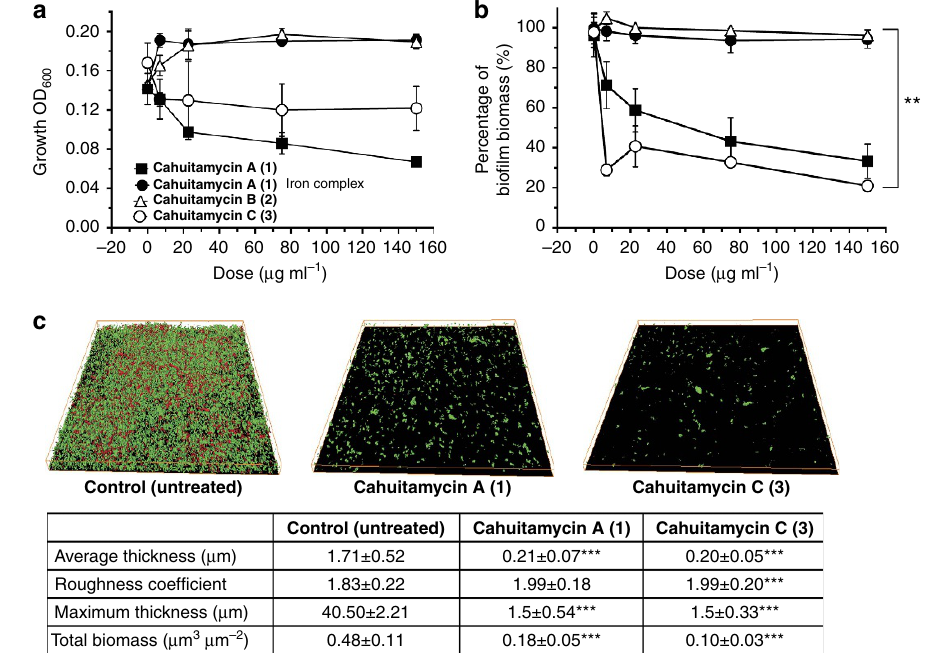
Figure 5 | Biological activity of cahuitamycins A–C (1–3). ( a ) Growth of A. baumannii ATCC 17978 and ( b ) inhibition of biofilm in the presence of cahuitamycins A–C ( 1 – 3 ) and iron complex of 1 compared with control. Results are the average of three replicates ± s.d. Student’s t- test was used for statistical analysis, ** indicates P o 0.01. ( c ) 3D image of A. baumannii ATCC 17978 biofilm after 22h of incubation. Control was untreated, and 1 and 3 were treated at 240nM. Images were acquired using a confocal microscope with a (cid:2) 60 objective lens. Results are the average of five replicates. Student’s t- test was used for statistical analysis, *** indicates P o 0.001 compared with